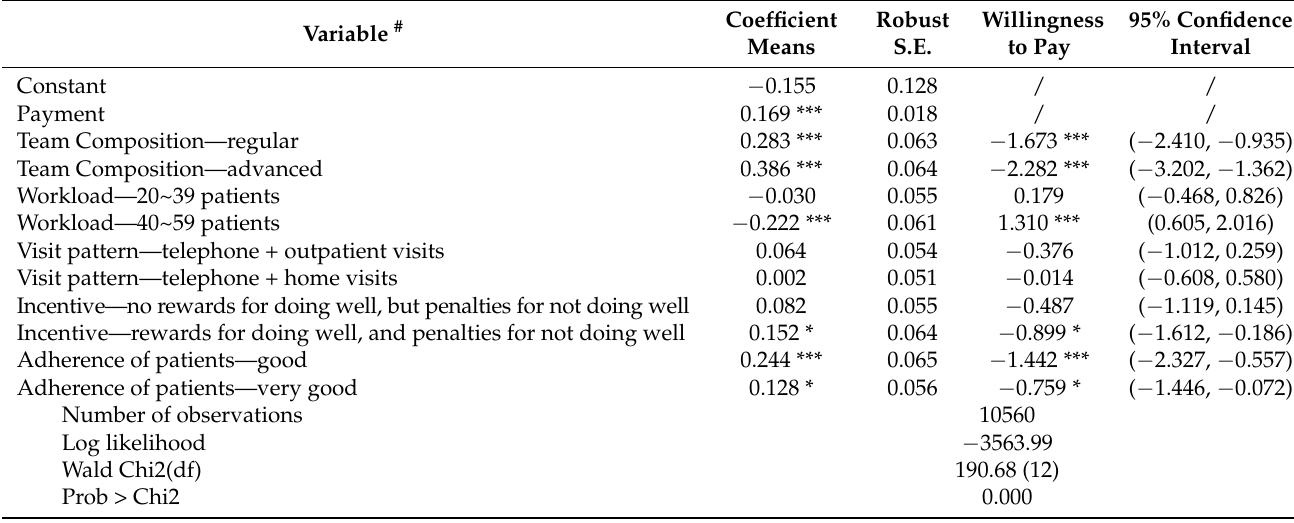
Table 3. Model results and willingness to pay (WTP).